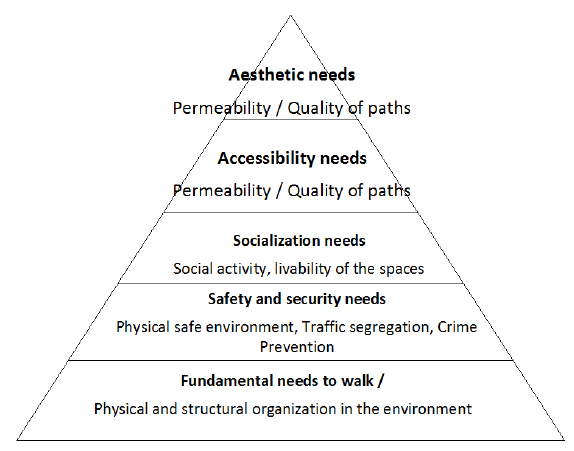
Figure 5. The hierarchy of human needs regarding to walkability (Developed by